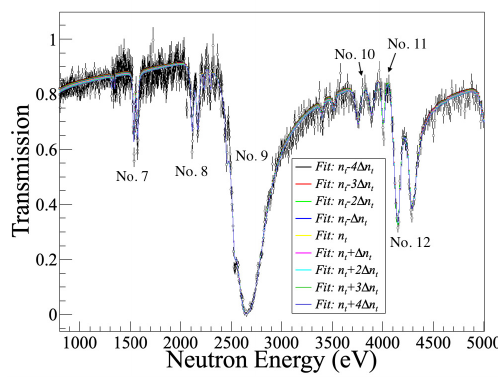
Figure 5. Same as Fig. 4, but in the neutron energy region be- tween 800 to 5000 eV.